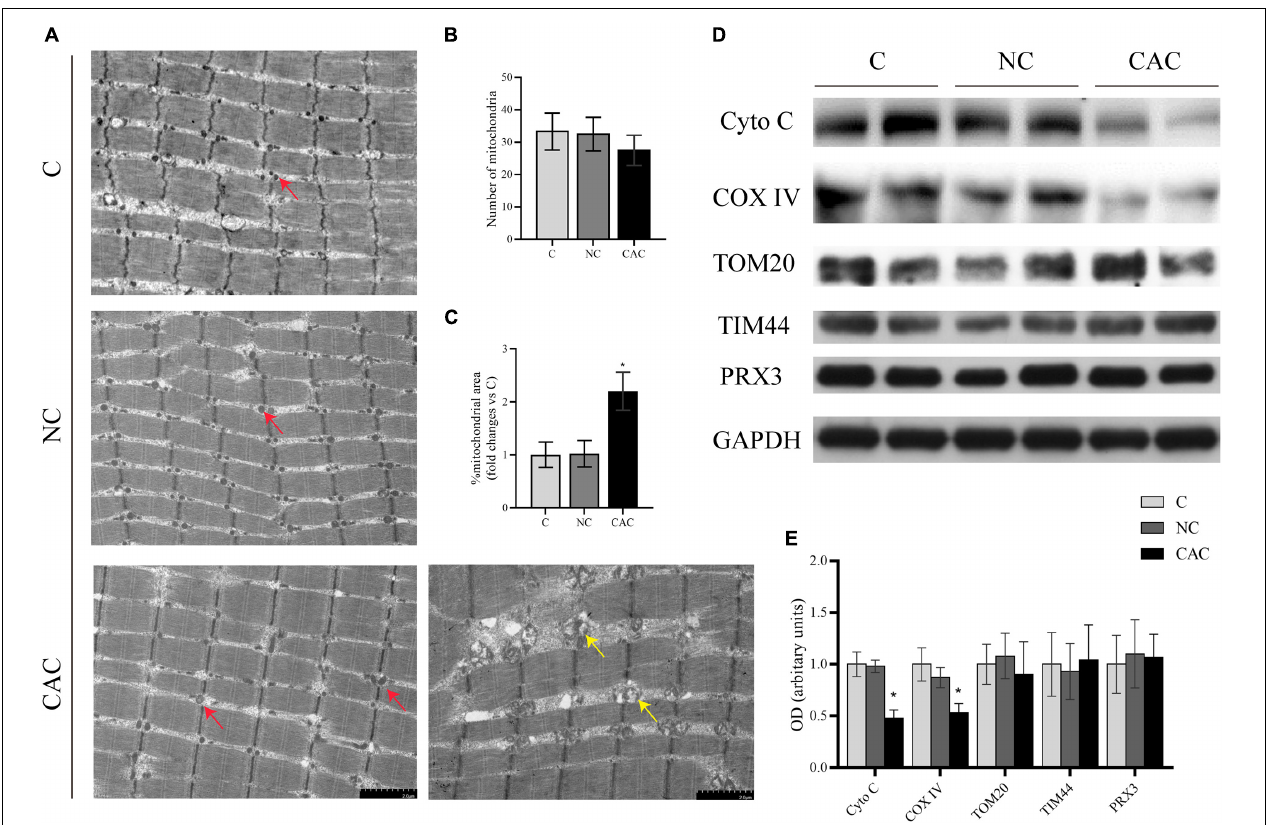
FIGURE 2 | (A) Typical images under a transmission electron microscope. Red arrow indicates the normal mitochondrion, yellow arrow indicates the swollen and abnormal mitochondrion. (B) Quantification of mitochondrial number from the area of 96.9 µ m 2 ( n = 3). (C) Quantification of mitochondrial area. (D) Levels of Cyto C, COX IV, TOM20, TIM44, and PRX3 by Western blot. (E) Quantification of (D) C, control, patients with benign disease; NC, patients of non-cachexia; CAC, cancer patients with cachexia. * p < 0.05. Data are displayed as mean ± standard